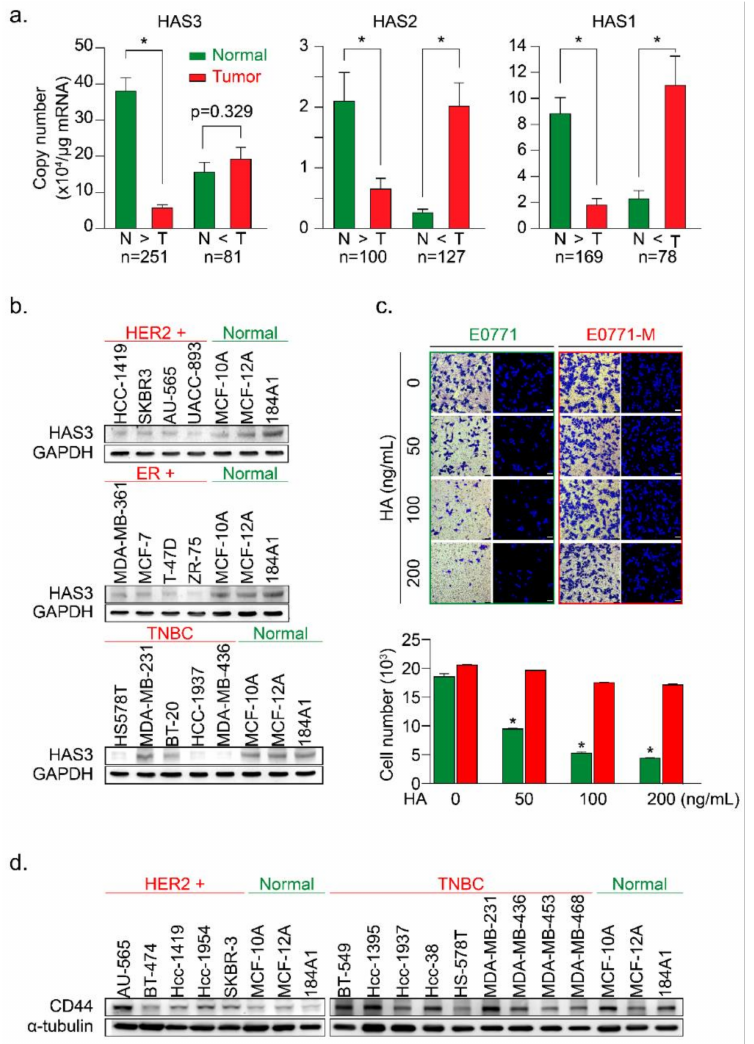
Figure 1. The HAS3 protein was preferentially overexpressed in normal breast epithelial cell lines and adjacent normal tissues surrounding the breast tumor. ( a ) The HAS family (HAS1, 2, and 3) mRNA expression profiles of paired human breast tumor (red bars) and normal (green bars) tissues were determined by real-time PCR. Copy numbers ( × 10 4 per µ g of mRNA) were calculated from mean real-time PCR data; error bars indicate 95% confidence intervals. Data were analyzed with a paired t-test, and the presented p -values are two-sided. Normal tissue (N) vs. tumor tissue (T) in each group. * p < 0.0001; ( b ) The protein expression of HAS3 in 13 breast cancer and three normal breast epithelial cell lines was detected by immunoblotting. The protein expression of GAPDH is shown as a protein loading control; ( c ) A Transwell assay was conducted to test the HA-induced anti-migratory effects. HA (0–200 ng/mL) was added in the lower chamber coculture with the syngeneic mouse breast cancer (E0771, green bars) and lung-metastatic E0771 (E0771-M, red bars) cancer cells in the upper chamber. The data shown indicate the number of migrated mouse (E0771 vs. E0771-M)